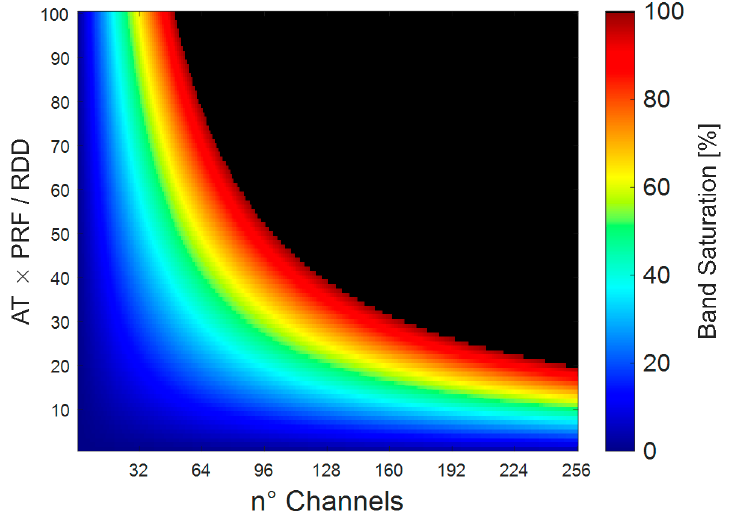
Figure 6. Expected saturation level of PCIe 3.0 ×8 connection towards NVIDIA Jetson AGX Xavier. The transfer band saturation percentage was color coded. Table 3. Vector Flow Imaging Method Processing Time Test.